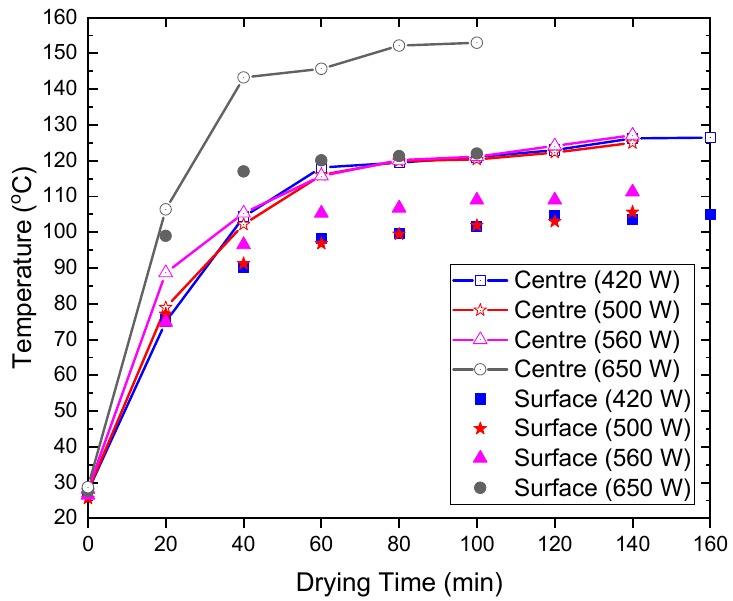
Figure 6. The temperature responses versus drying time of the STR 5L at the centre and surface of the samples when different microwave power levels were applied.